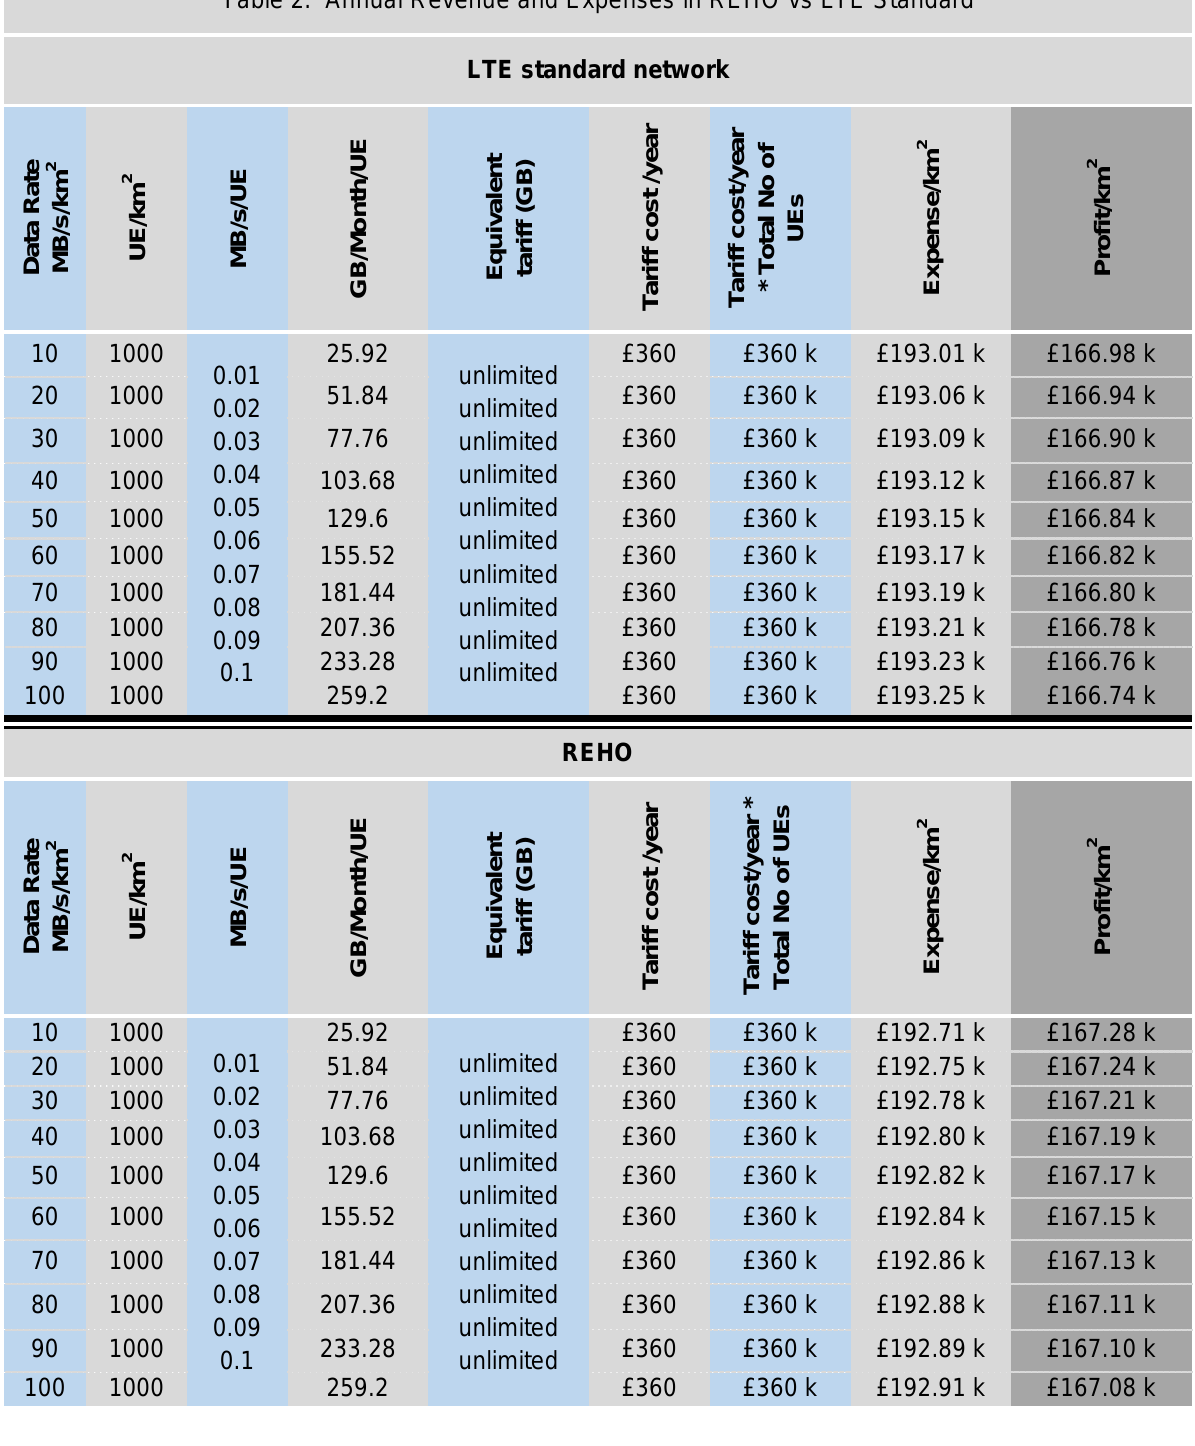
Table 2. Annual Revenue and Expenses in REHO vs LTE